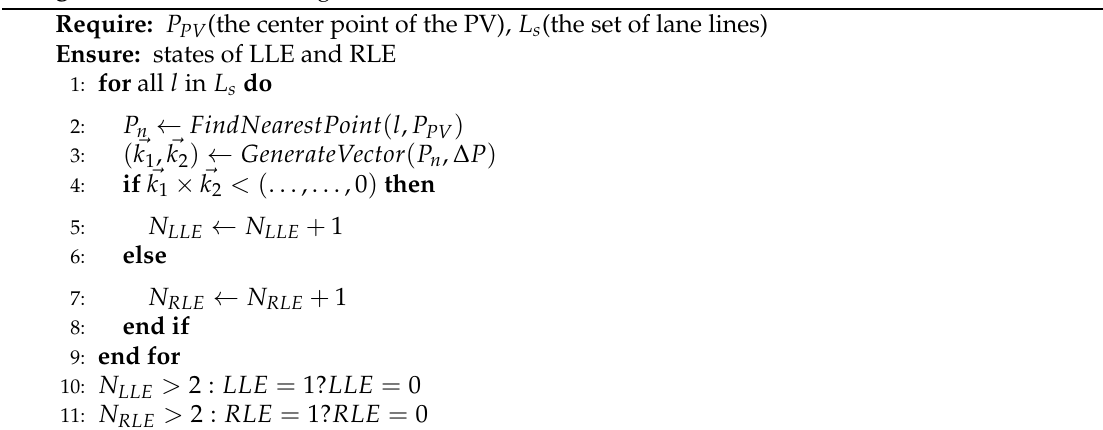
Algorithm 1: Extraction algorithm for road-structure features: LLE and